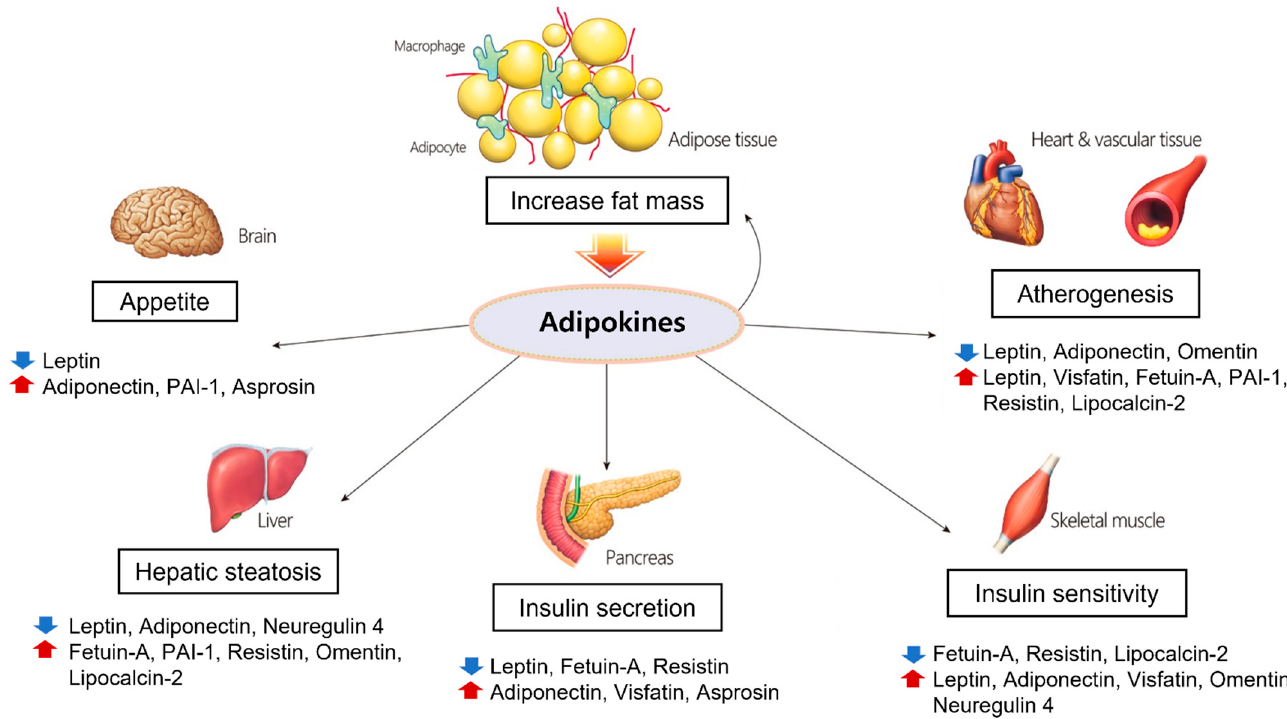
Figure 1. Physiological processes regulated by adipokines in each organ. Adipokines secreted from adipose tissue play important roles in adiposity, glucose and lipid metabolism, and atherosclerosis.